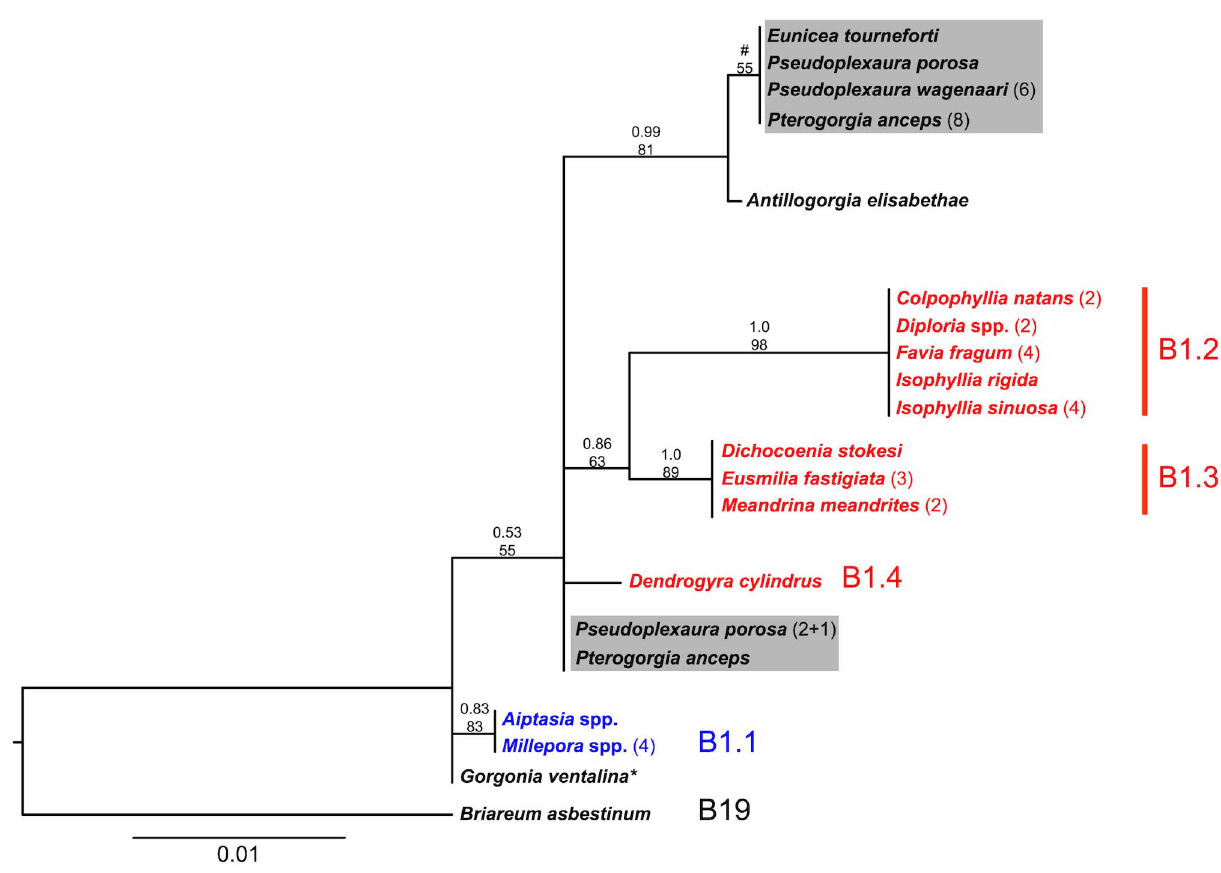
Figure 4. A maximum likelihood phylogenetic tree based on microsatellite flanking regions of B1 Symbiodinium . The phylogeny includes B1 Symbiodinium from the four gorgonian species in this study (highlighted in gray), from other gorgonian corals [47], from scleractinian and hydrozoan corals [36], as well as Symbiodinium minutum from Aiptasia , a sea anemone [47]. Branch tips are labeled with host species and sample sizes when n . 1. Gorgonian and scleractinian coral species are shown in black and red, respectively, and the other cnidarians are shown in blue. B1 lineages described by Finney et al. [36] are listed besides the host taxa. Numbers above the branches are the posterior probability above the maximum likelihood consensus support for each group. B1 Symbiodinium from 16 of 19 gorgonian colonies sampled clustered in a phylogenetic group with high posterior probability (top gray box). Three gorgonian colonies were placed outside of this clade (bottom gray box) and were most closely related to Symbiodinium isolated from Pseudoplexaura porosa from Florida (indicated with ( + 1)) and cultured Symbiodinium from Gorgonia ventalina [47] indicated with *. ( # ) indicates a group recovered in the maximum likelihood tree, but not the Bayesian phylogenetic tree.